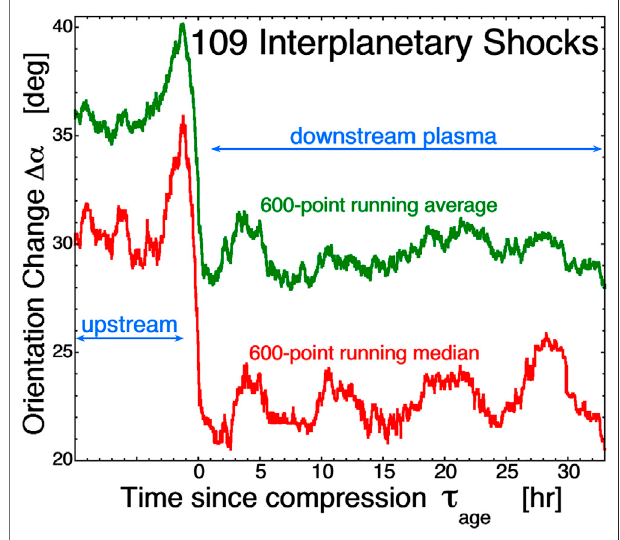
FIGURE 9 | For 109 interplanetary shocks, the change in angle of the normals between one current-sheet crossing and the next are plotted. The green curve is the 600-point running average of all values and the red curve is the 600-point running median of all of the